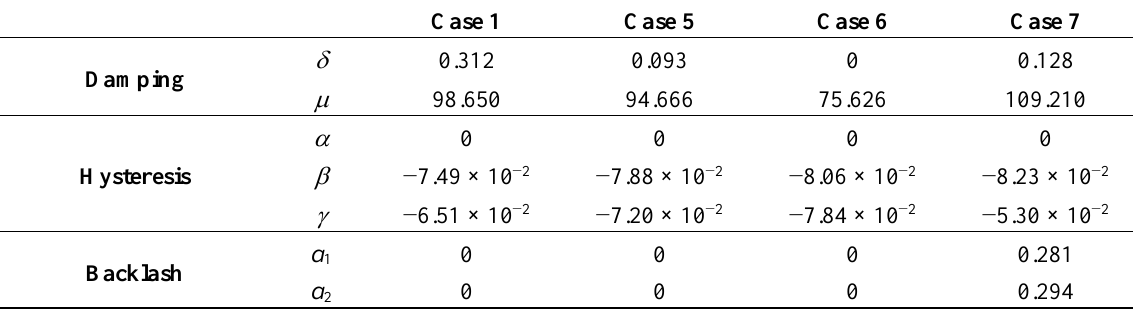
Figure 5. Progression of the solution. Table 6. Results for parameter estimation for the training cases using